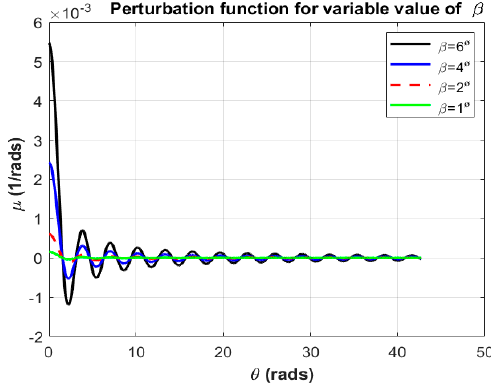
Figure A1. Variation of the perturbation function.